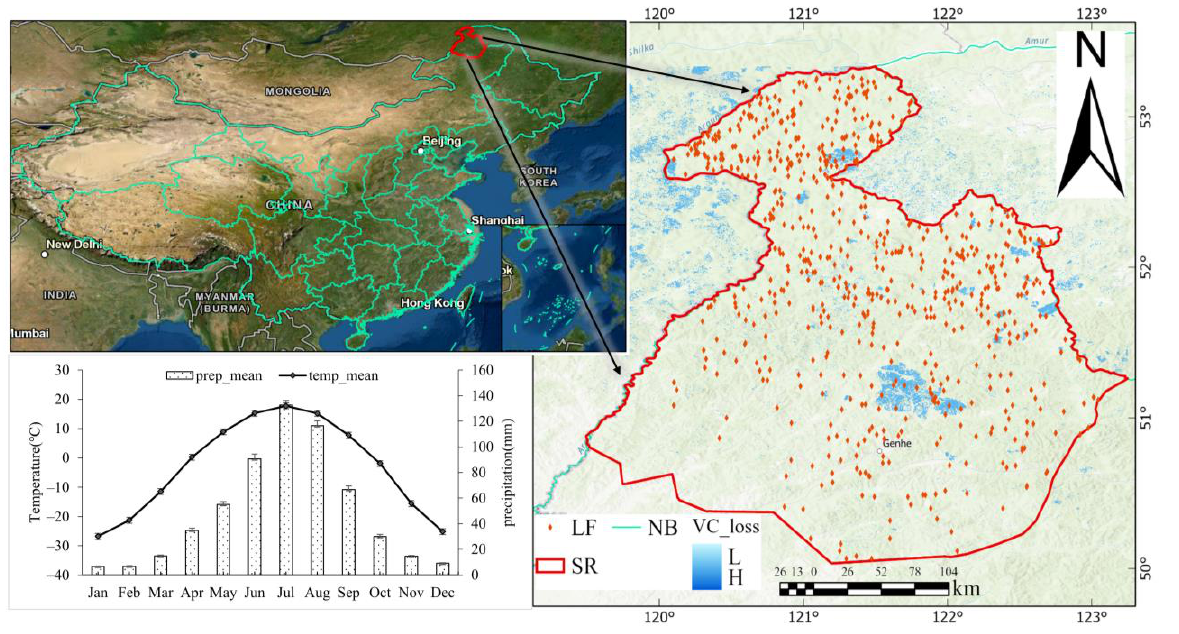
Figure 1. Study region maps: upper left is location of study region; lower left is historical monthly precipitation and temperature; right is lightning-induced fires and historical (2001 − 2021) vegetation loss (LF: lightning-caused fires, SR: study region, NB: national border, VC_loss: vegetation loss).